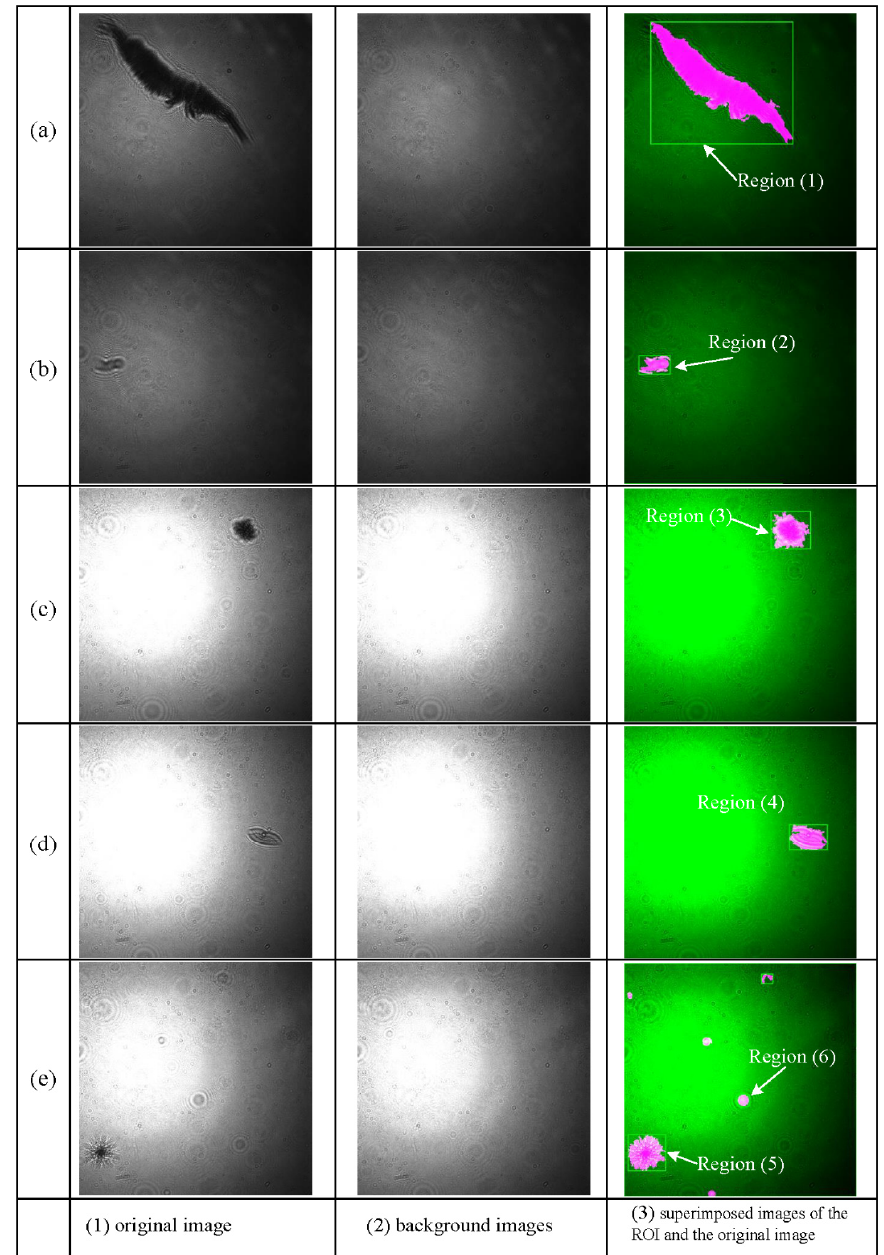
1–6 in Figure 13, respectively, and the purple vertical lines represent the positions of the manually selected focus planes. Figure 15 shows an image of the plankton on the focus plane automatically obtained using the SOL_VAR method.